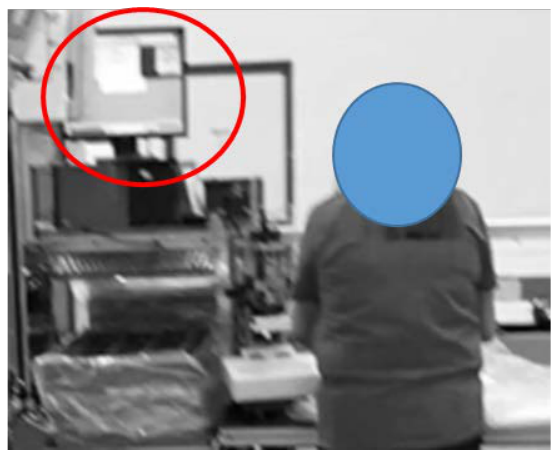
Figure 11. The criticality that emerged in P4 of the Alpha workstation.